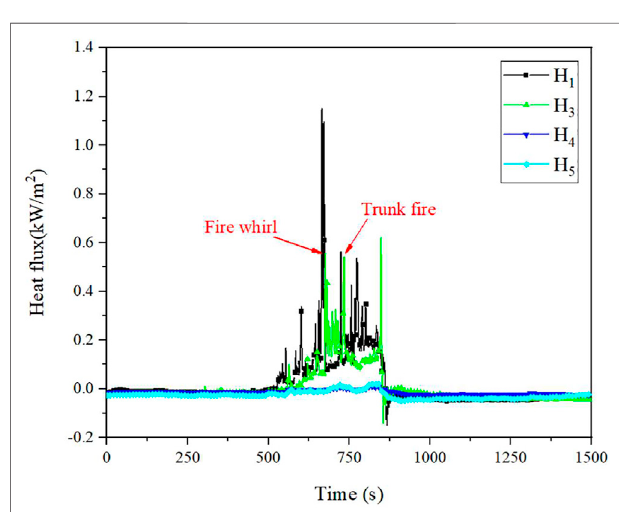
FIGURE 11 | Evolutions of heat fl ux in test